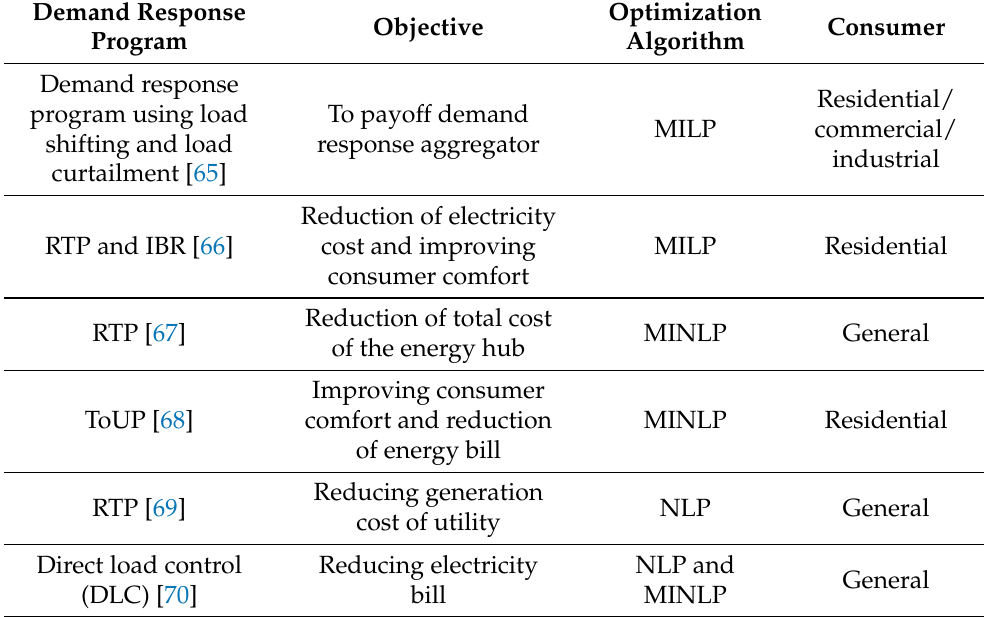
Table 4. Conventional techniques based on LP and